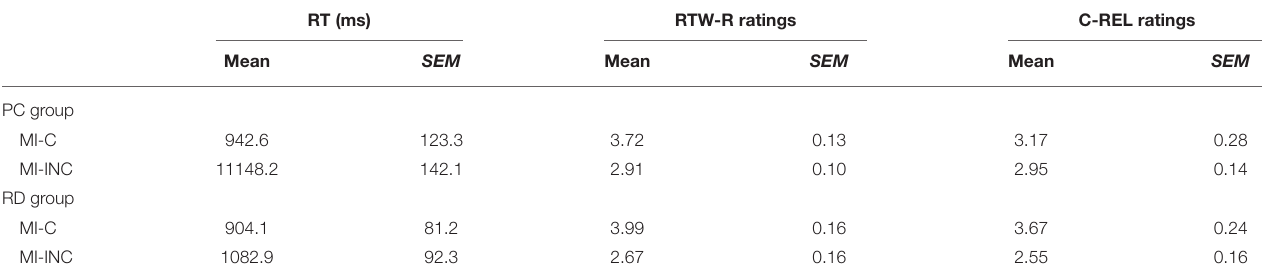
TABLE 2 | Comparisons of the response times (RTs), return to work readiness (RTW-R) ratings, and content relevance (C-REL) ratings for the MI-congruent and incongruent statements between participants in the pre-contemplation (PC) and readiness (RD)